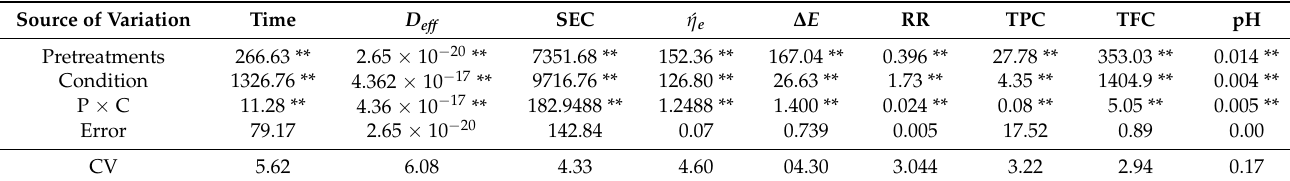
Table 2. Analysis of variance (ANOVA) for the effect of pretreatments and different condition of two drying methods on time, effective moisture diffusivity coefficient ( D eff ), specific energy consumption SEC , energy efficiency ( ´ η e ), the total color difference ( ∆ E), RR, TPC, TFC, and pH of